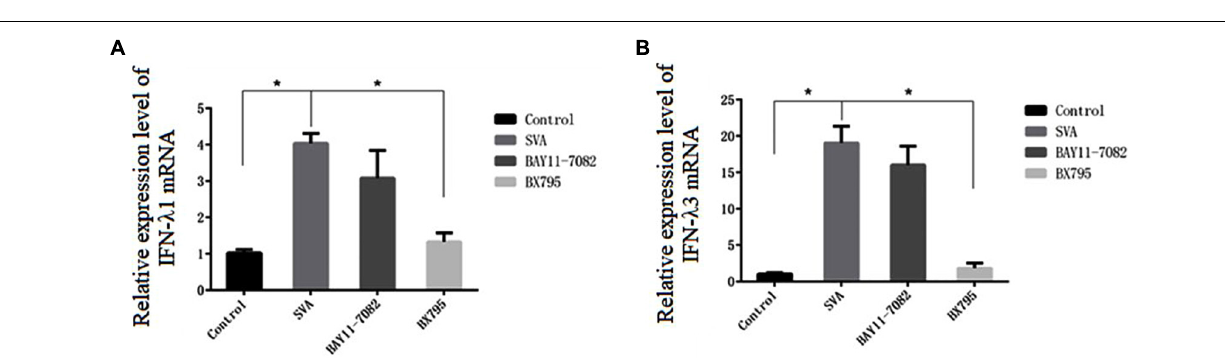
FIGURE 8 | The effect of different inhibitor treatments on type III interferon mRNA expression in SVA-infected PK-15 cells. The x -axis represents the different inhibitor treatment groups, and the y -axis represents the fold change after SVA infection (* P < 0.05). (A) The mRNA expression of IFN- λ 1. (B) The mRNA expression of IFN- λ